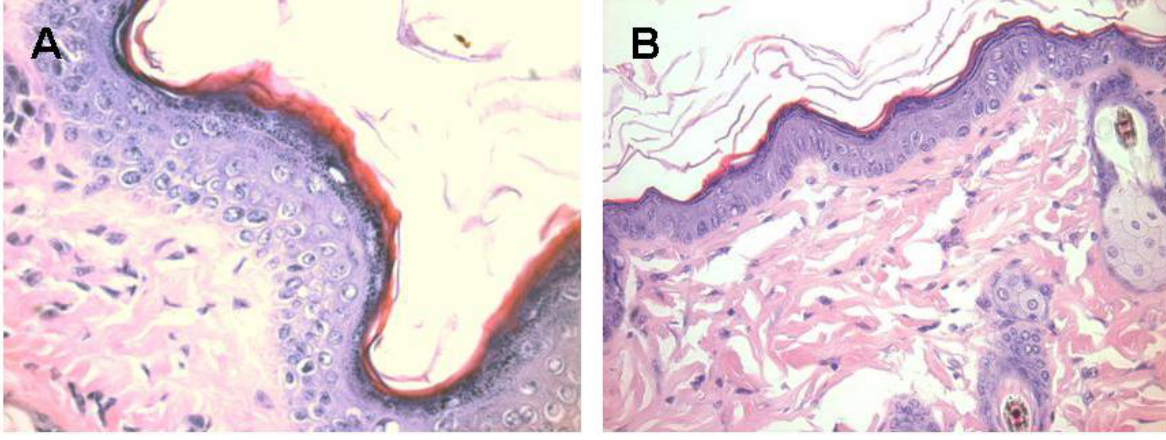
Figure 6. Melanocytes activation following subcutaneous injection of 1.0 mg 